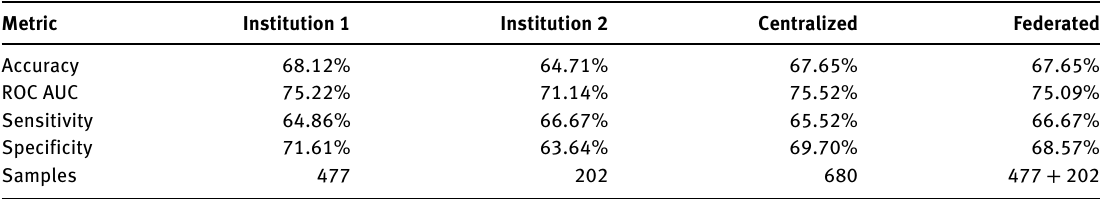
Table 1: Results of the centralized and FL analysis, showing the mean accuracy, ROC AUC, sensitivity, specificity and number of patient samples for Institution 1 and 2 individually, the FL model and the centralized ML model.